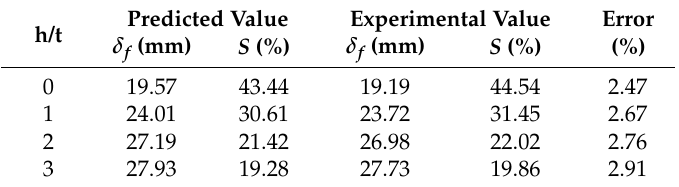
Figure 13. FE simulation and experimental verification based on springback of creep aged AA7050 ribbed panel with h/t = 1 (unit: mm). Table 4. Comparison between experimental and predicted values of springback.